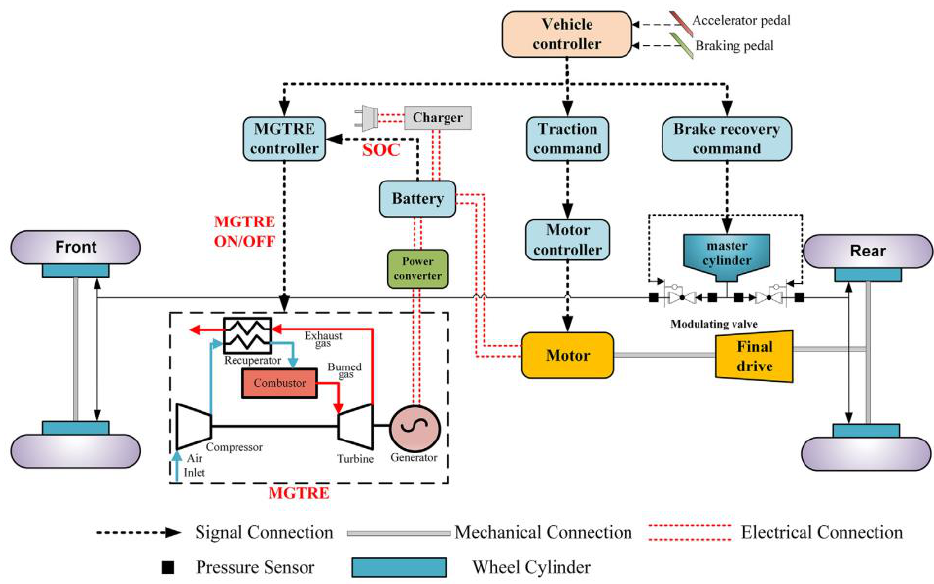
Figure 22. Scheme of a REEV with a MGT [151].